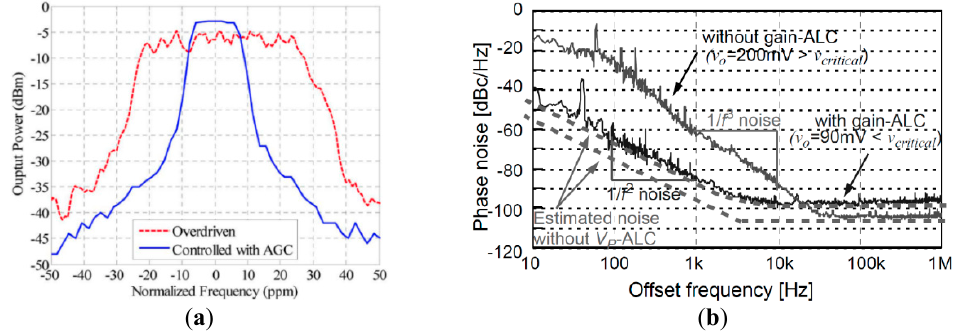
Figure 25. ( a ) The effect of automatic gain control due to the nonlinearity of the resonator on time domain frequency stability of a MEMS oscillator [208]. © 2009 IEEE. Reprinted with permission from A Highly Integrated 1.8 GHz Frequency Synthesizer Based on a MEMS Resonator by Nabki in J. Solid-State Circuits , 2009; and ( b ) the effect of automatic gain (level) control on the phase noise performance of a MEMS oscillator [237]. © 2003 IEEE. Reprinted with permission from Influence of automatic level control on micromechanical resonator oscillator phase noise. by Lee in Proceedings of the IEEE International Frequency Control Symposium, 2003.